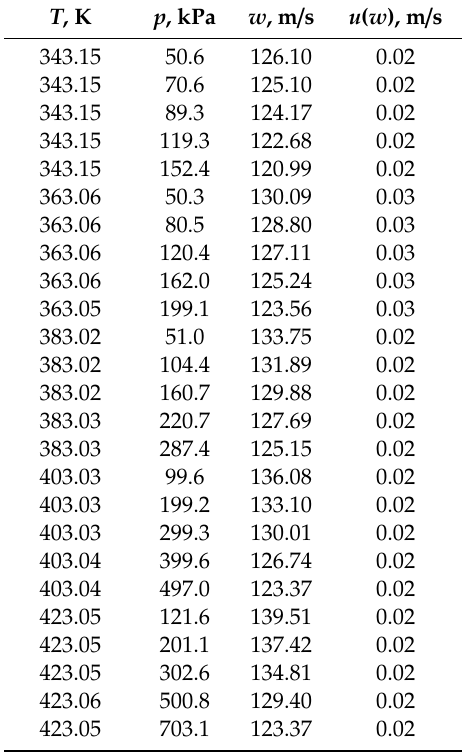
Table 3. Sound velocity data in the vapor phase for